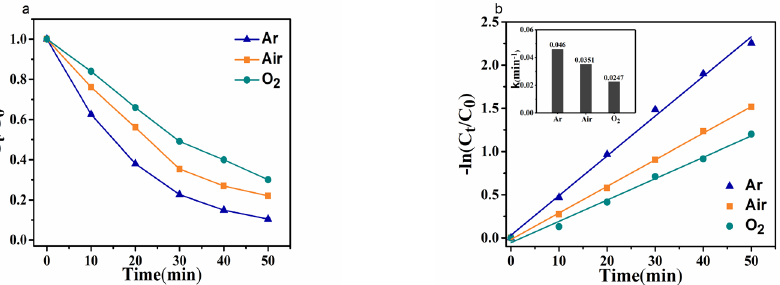
Figure 5. ( a ) The degradation efficiency of PFOA under plasma from three different gases. ( b ) First-order kinetics and kinetic constants under plasma from different discharge gases (the lines were fitted results and the inset shows the kinetic constants). Experimental conditions: negative pulsed power, peak voltage = 12 kV, power frequency = 6 kHz, pulse width = 500 ns, average power = 22 W.